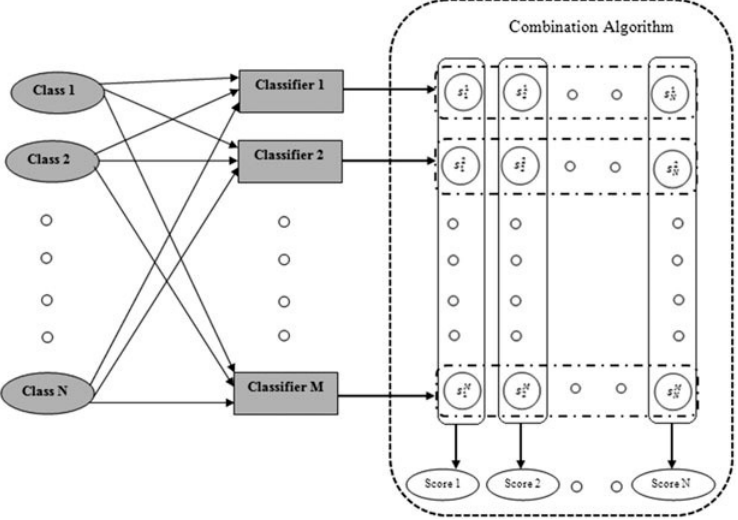
Figure 6. Classifier combination takes a set of (cid:1871) (cid:3036)(cid:3037) score for class (cid:1861) by classifier (cid:1862) and produces combination scores (cid:1845) (cid:3036) for each class (cid:1861) [34].